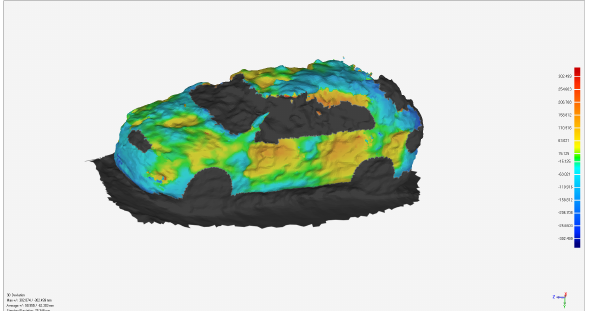
Figure 5. The distance between the ground truth model and the SfM reconstruction for the test object ˇSkoda